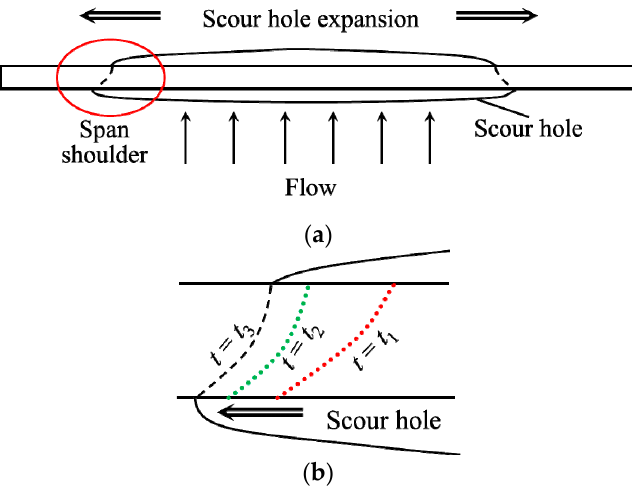
Figure 1. Aim of investigation of this study: ( a ) Top view of scour hole development; ( b ) problem investigated in this study.